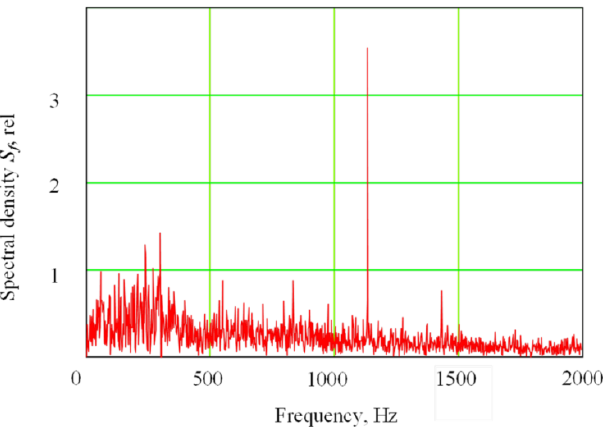
Figure 4. Low-frequency spectrum area of secondary current in plasma at the electron beam welding with electron beam oscillation across the joint (electron beam power P = 2.5